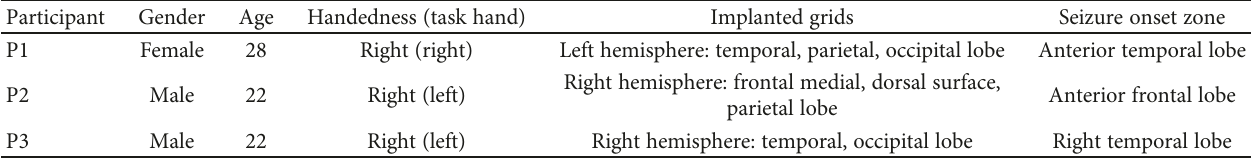
Table 1: Participant overview and grid